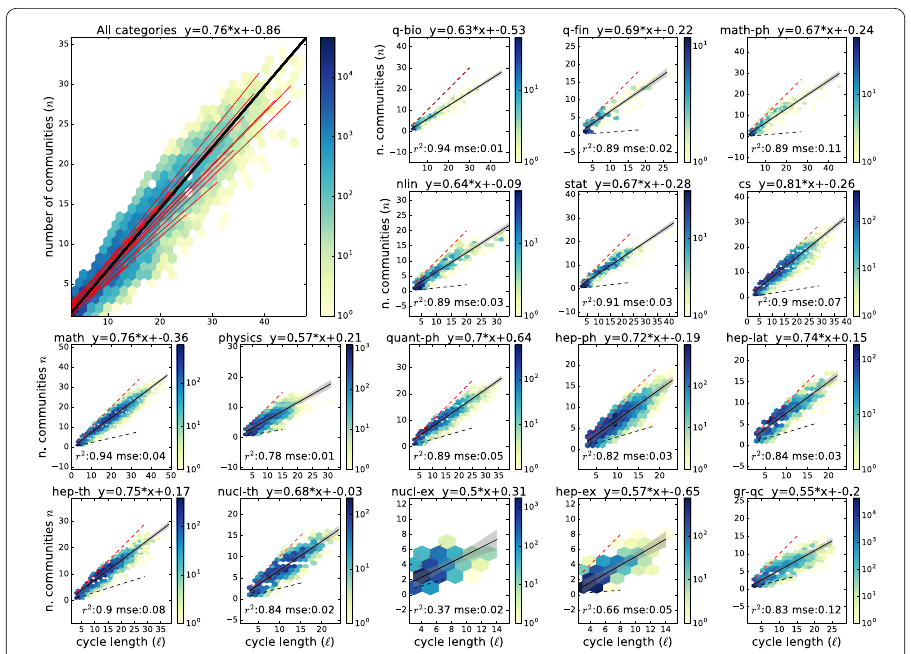
Figure 8 Cycles and community counts. Color intensity represents the number of cycles of length (cid:9) linking n communities. Red dashed lines represent the upper bound on the number of traversed communities, while black dashed lines the random expectation. We provide also a linear fit to the data (black solid lines, with confidence intervals) showing that cycles are strongly associated with community